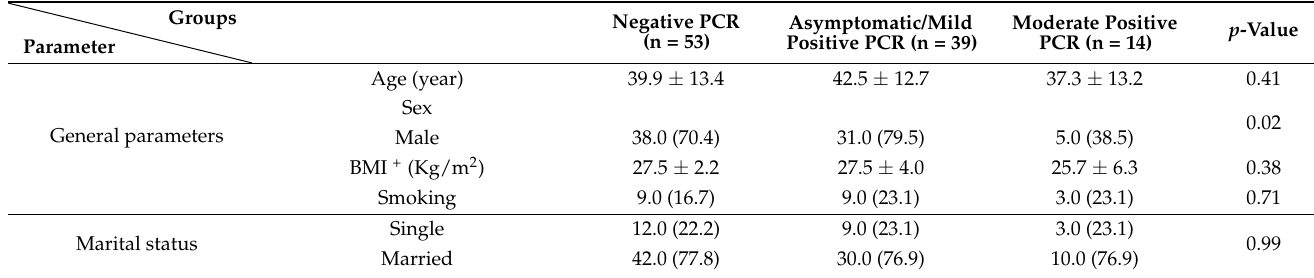
Table 1. General characteristics, clinical presentations, and comorbidities of patients infected with SARS-CoV-2 and matched controls